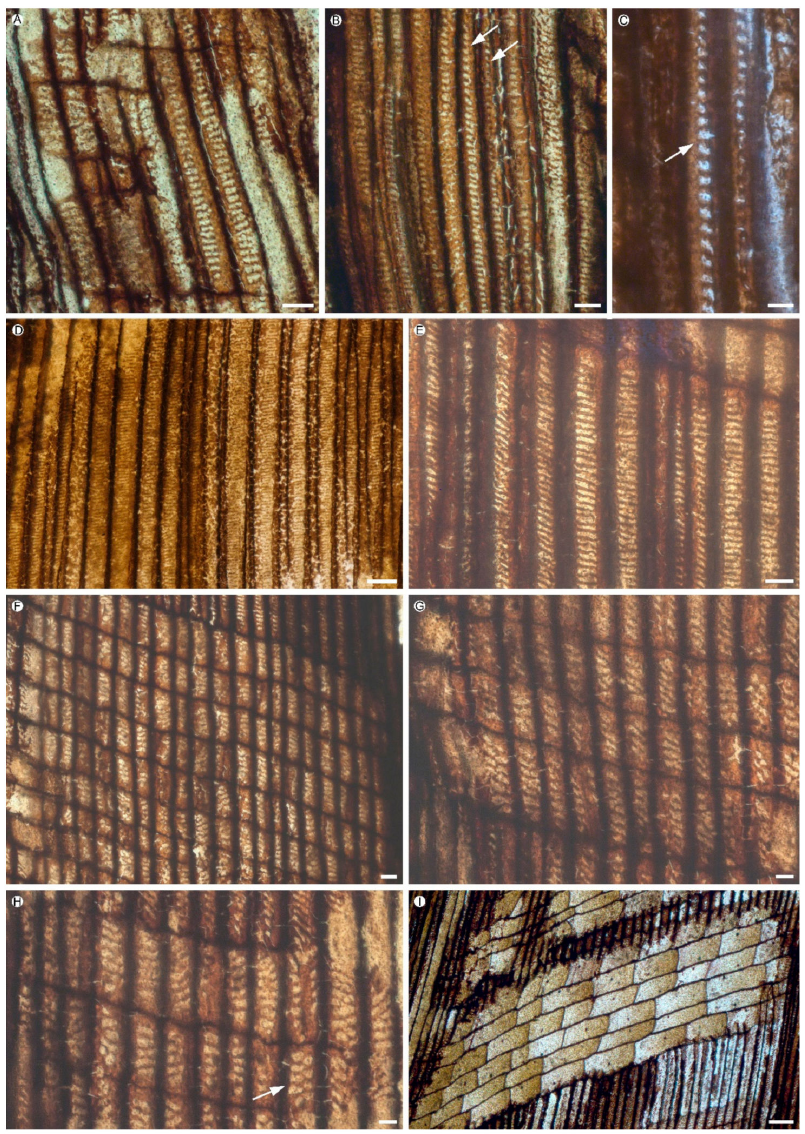
Figure 6. The xylem structure of Tingia unita from the Taiyuan Formation of Wuda Coalfield, Inner Mongolia. ( A – I ) Radial section of stem. ( A – E ) Showing the uniseriate oval (white arrows) and unis- eriate scalariform bordered pits on the tracheid walls of secondary xylem. Scale bars: ( A ) = 20 µ m; ( B ) = 20 µ m; ( C ) = 10 µ m; ( D ) = 50 µ m; ( E ) = 20 µ m. Collection numbers: ( A – C ) PB201150; ( D , E ) PB201152. Slide numbers: ( A ) PB201150-8; ( B , C ) PB201150-11; ( D ) PB201152-9; ( E ) PB201152-12. ( F – H ) Showing the uniseriate scalariform to biseriate alternately elliptical (arrow) cross-field pits. Scale bars: ( F ) = 20 µ m; ( G ) = 10 µ m; ( H ) = 10 µ m. Collection number: PB201152, slide number: PB201152-12. ( I ). Showing the ray cells, scale bar = 50 µ m. Collection number: PB201152; slide number: